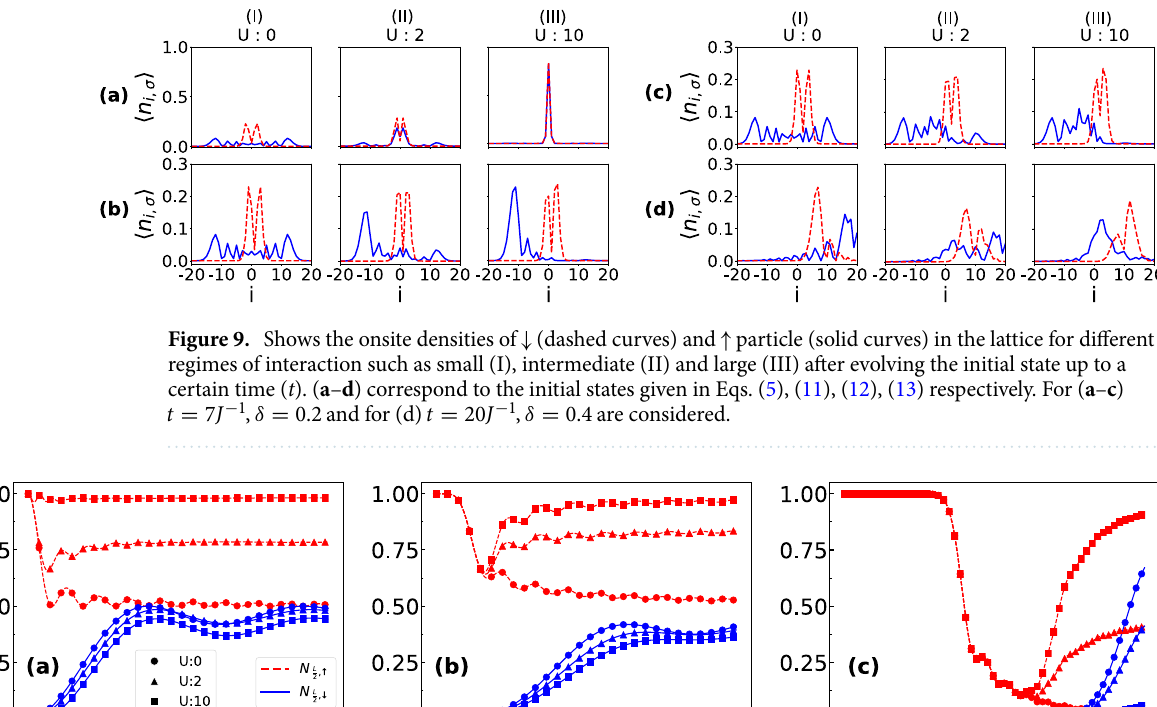
(dashed curves) and N L (solid curves) are shown for 2 , ↑ 2 , ↓